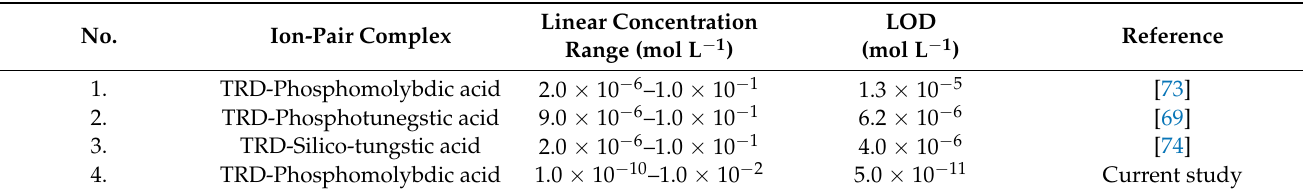
Table 7. Comparative results between the suggested conventional and functionalized TRD-PM and TRD-PM-CeO 2 /Al 2 O 3 nanocomposite coated wire